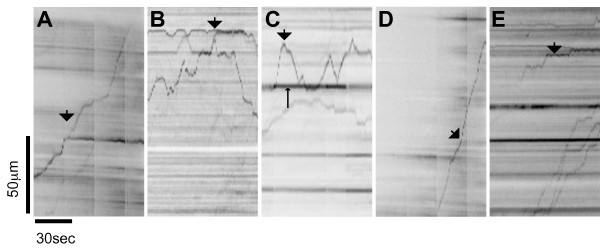
Examples of ASGFP transport behavior. Kymographs illustrating examples of ASGFP transport behavior. (A) One particle is clearly seen to bifurcate into two distinct particles (bold arrow). (B) Three starting particles briefly fuse to become one particle (bold arrow) before bifurcating again into two particles. (C) One particle (bold arrow) moves bidirectionally in and out of a stationary accumulation of ASGFP (fine arrow) (D) One particle moves without stopping or changing direction (bold arrow) (E) One particle gradually emerges from the background (bold arrow). (vertical scale bar = 50 μm, horizontal scale bar = 30s).